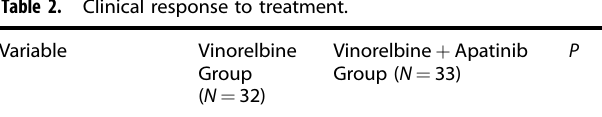
Best overall response among patients with measurable disease — no.